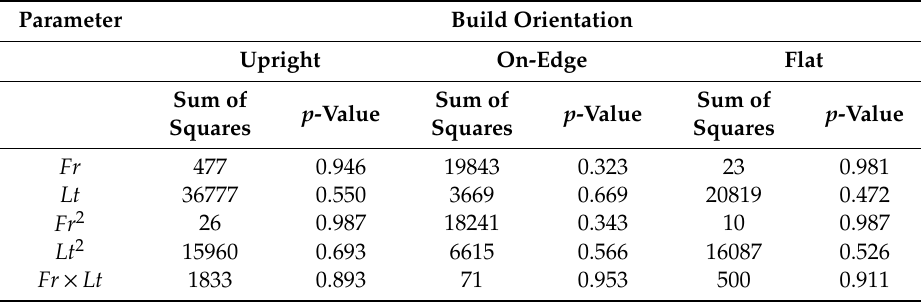
Table 1. ANOVA for dimensional deviations.